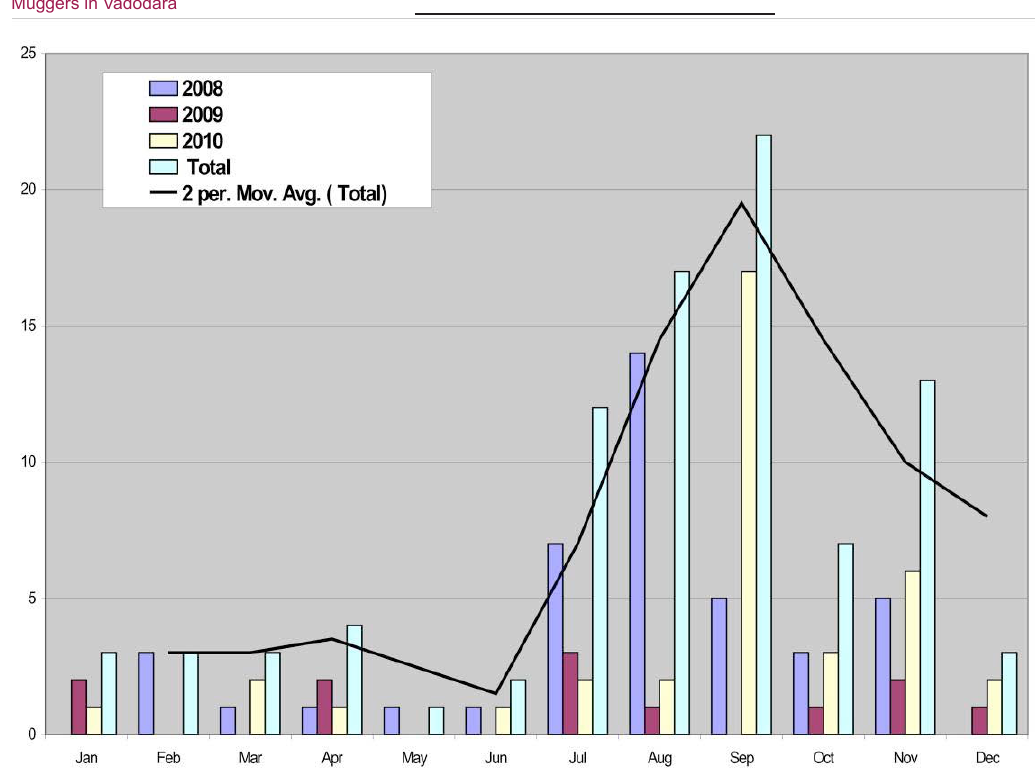
Figure 2. Mugger rescue in different months from Vadodara City during 2008 to 2010.